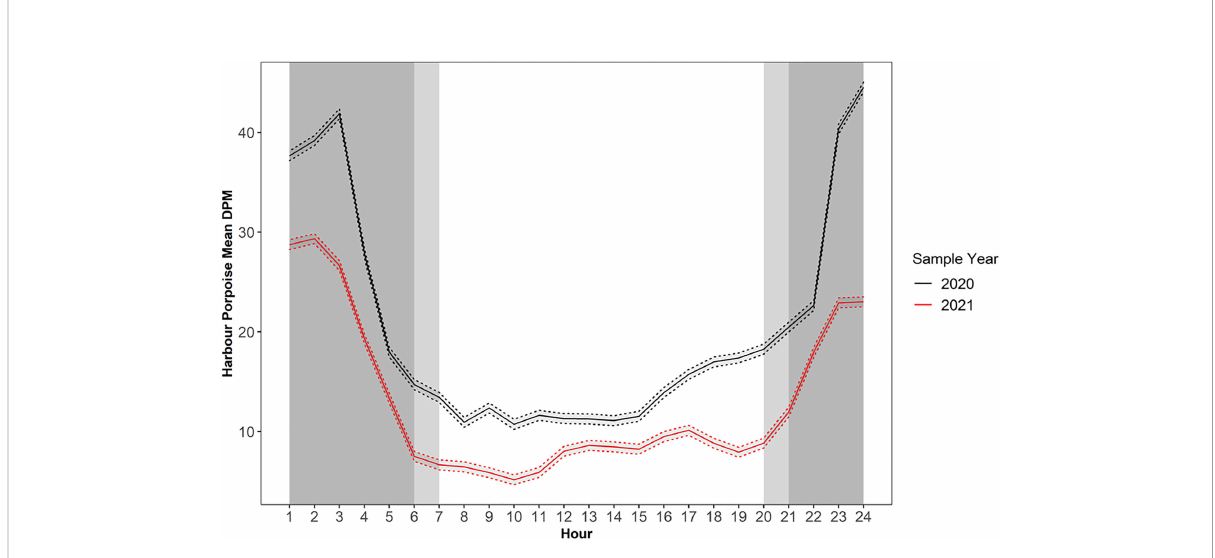
FIGURE 4 Diel variation in mean harbour porpoise Detection Positive Minutes (DPM) for F-POD data. Dashed line depicts the 95% con fi dence interval around the means. Note sample year begins January 24 th and ends January 23 rd and 20 th